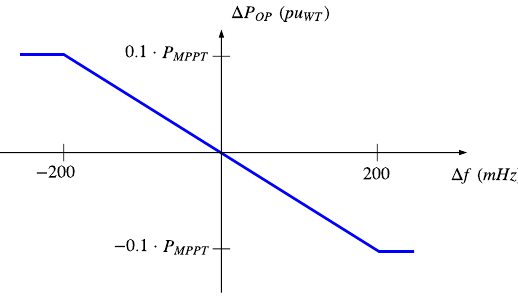
Figure 3. Proposed relationship between ∆ P OP and ∆ f for VSWTs during overproduction